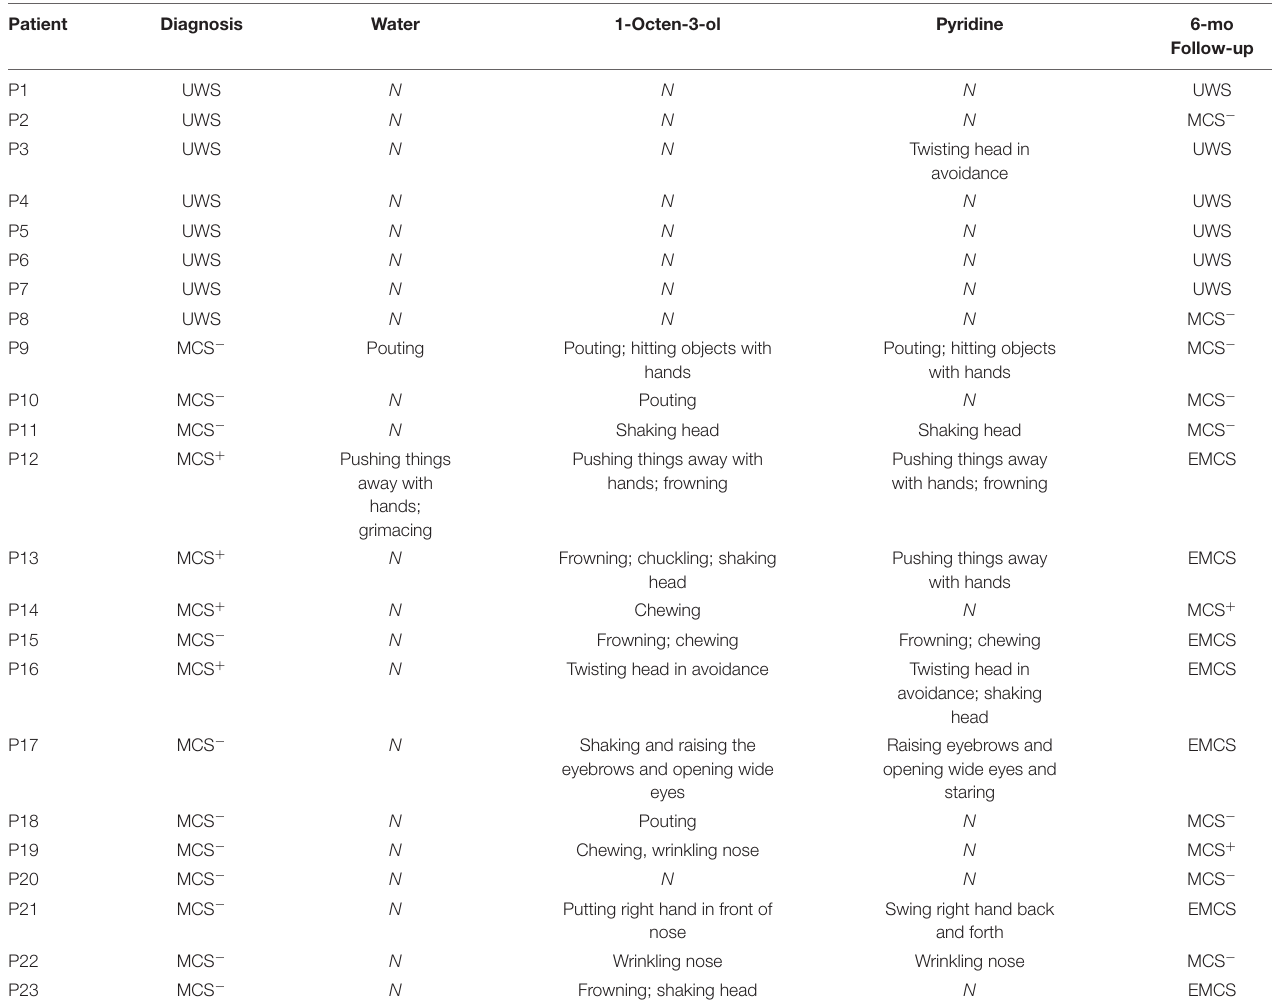
TABLE 1 | Different responses to different olfactory stimuli, and the information at the 6-month follow-up evaluation. Patient Diagnosis 6-mo